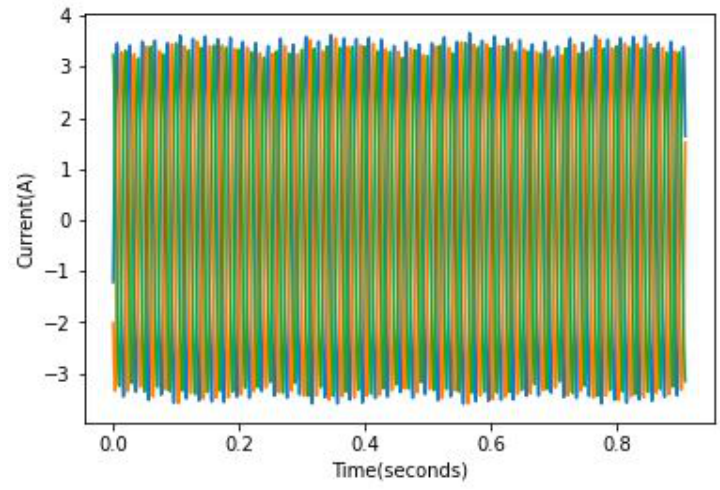
Figure 12. i a current in 2 BRB